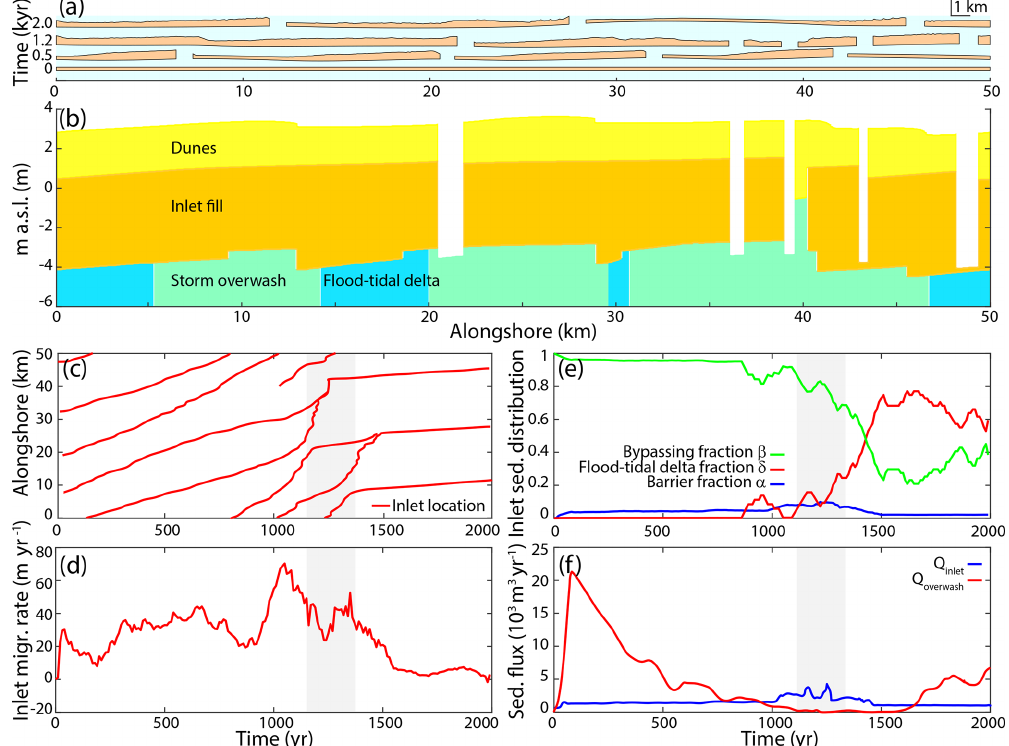
Figure 6. Example model run showing (a) a barrier island including tidal inlet through time, (b) inlet facies after approximately 1300 years, (c) inlet location through time (such that the slope of the line represents the migration rate), (d) average inlet migration rate, (e) the average fraction of alongshore sediment brought into the inlet transported to the downdrift coast ( β ), the flood–tidal delta ( δ ), and the barrier itself ( α ), and (f) the transgressive sediment flux due to overwash and due to flood–tidal delta deposition. Model code and animated model output can be found in Nienhuis and Lorenzo-Trueba (2019) and Nienhuis